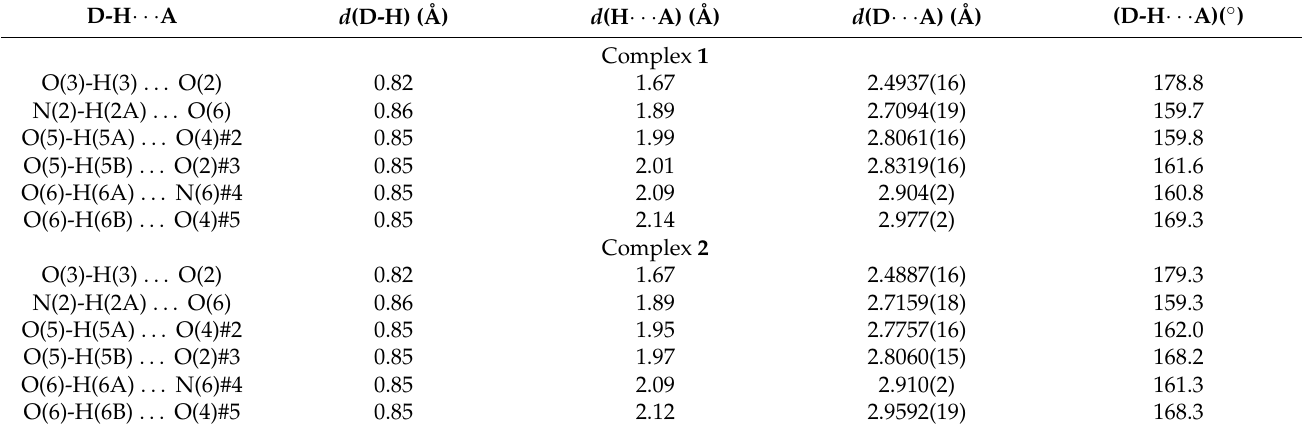
Figure 2. The two-dimensional structure of complex 2 linked by hydrogen bonds; yellow dashed lines represent intra-molecular hydrogen bonds, pink dashed lines represent hydrogen bonds of adjacent molecules, and blue dashed lines represent hydrogen bonds of adjacent chains. Table 3. Hydrogen bonds of complexes 1 and 2